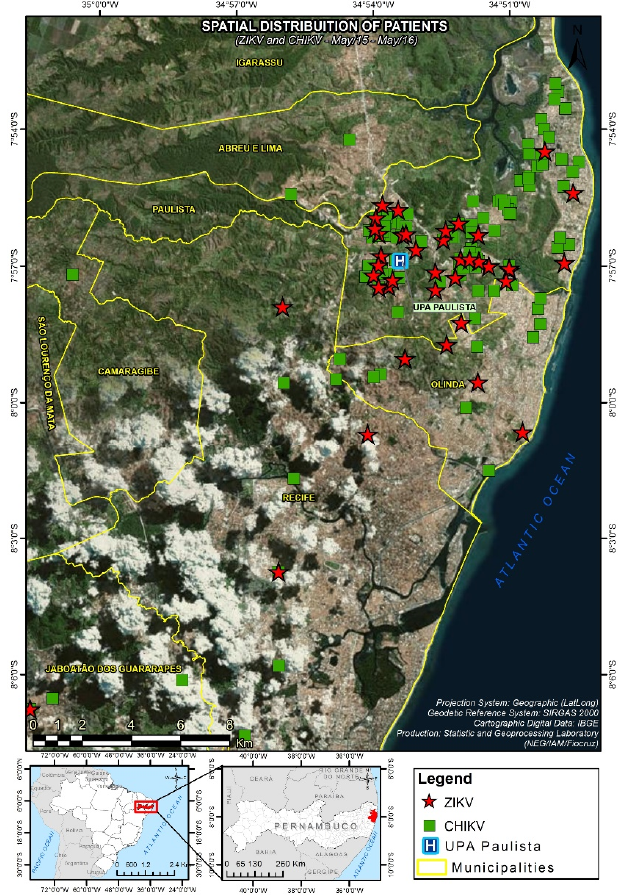
Figure 1. Mapped cases of Zika virus (ZIKV) and chikungunya virus (CHIKV) infections in Paulista, Pernambuco State, Brazil, in 2015-16. Note the green/forested areas surrounding the urban areas where cases were concentrated: an optimal interface for the establishment of sylvatic cycles of arbovirus transmission (this map was published in [10] ).